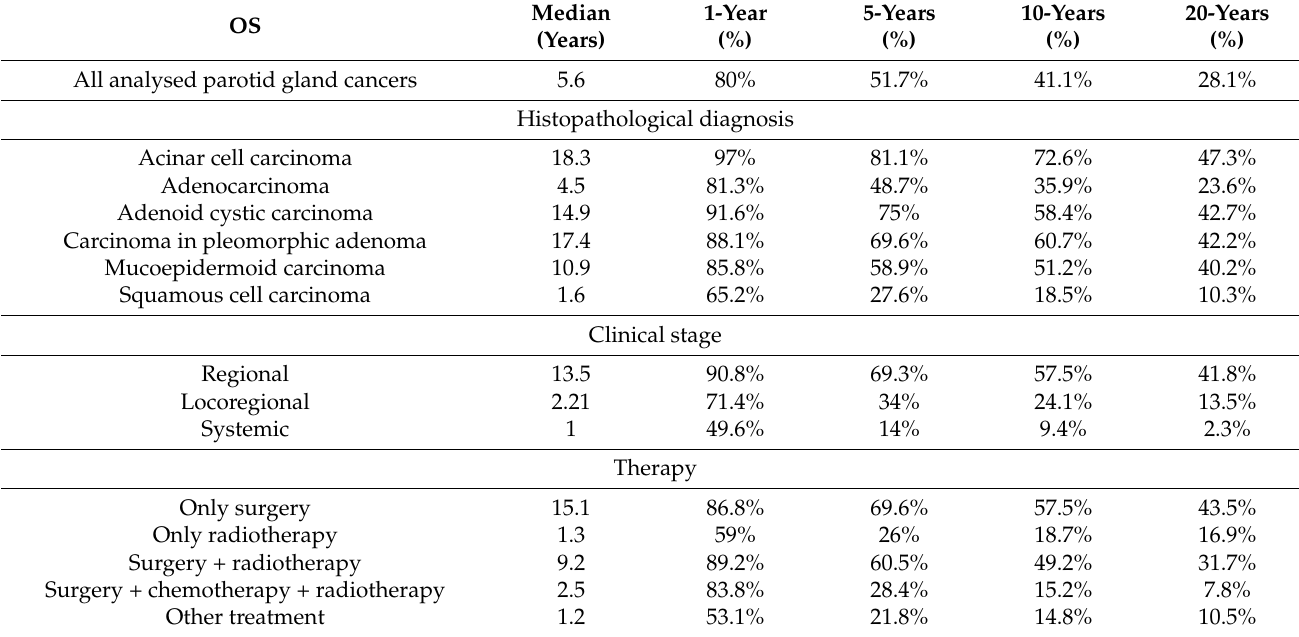
Table 3. OS of patients with parotid cancers stratified by histology, stadium, and therapy.